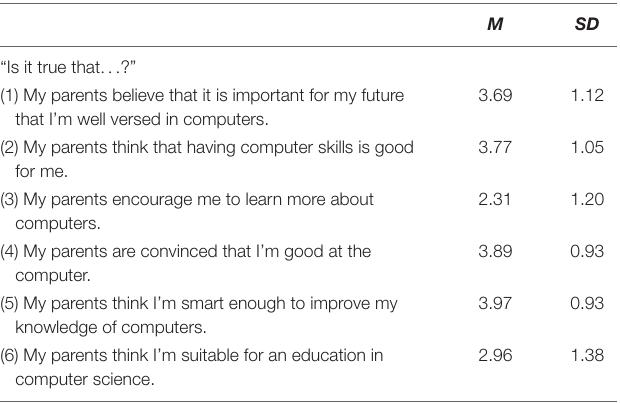
TABLE 3 | Perceived parental attitudes.